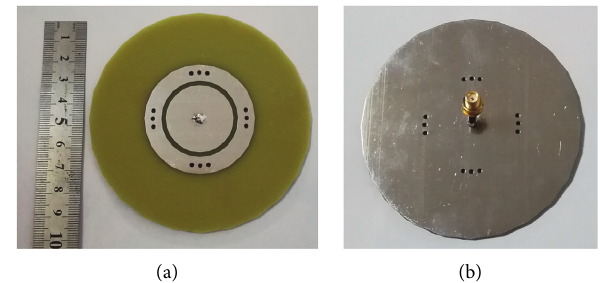
Figure 10: Photos of the proposed antenna. (a) The top view. (b) The bottom view.